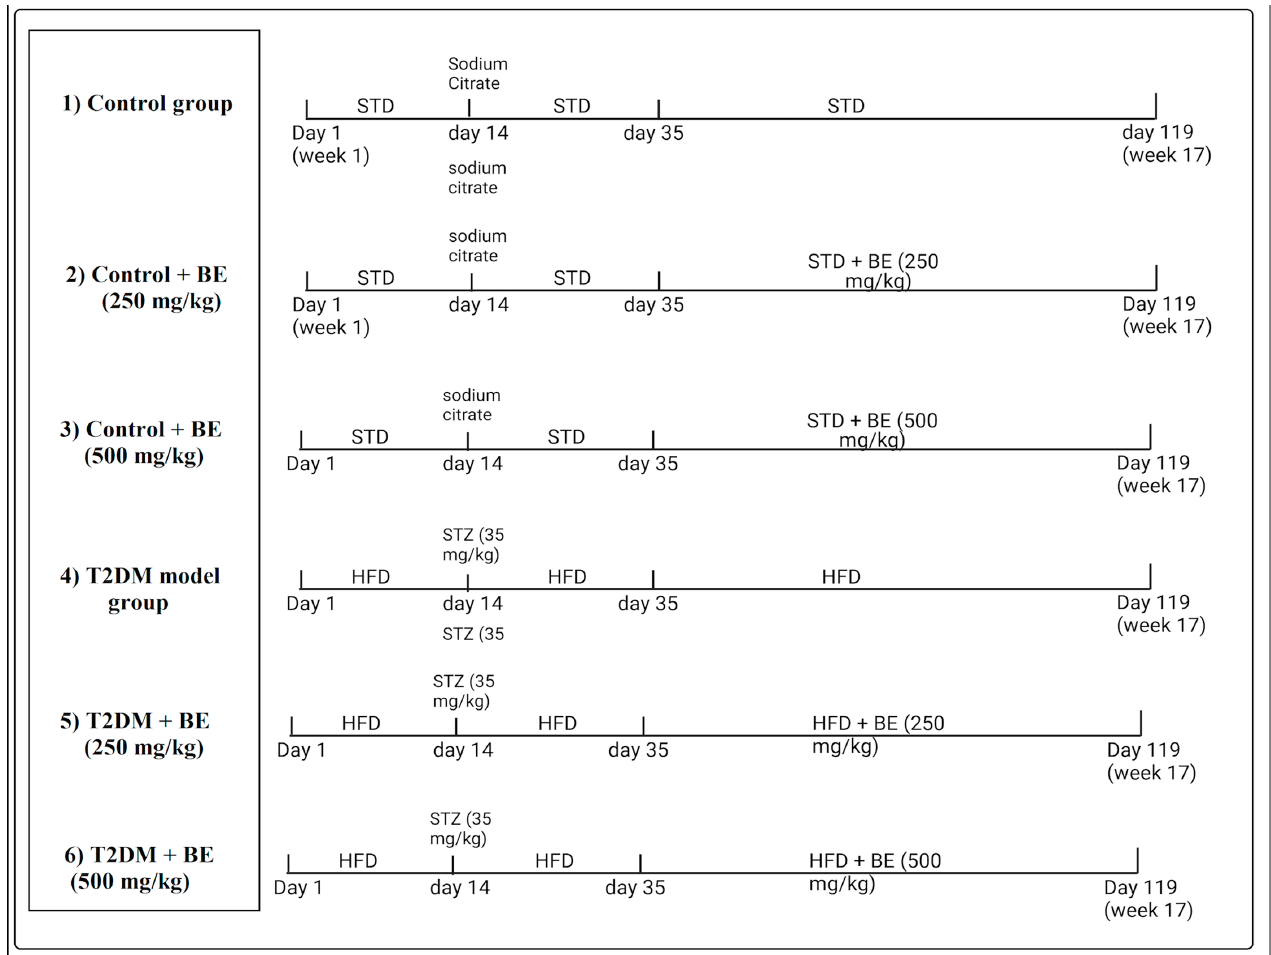
Figure 1. A diagram showing the different experimental groups and experimental design included in this study.